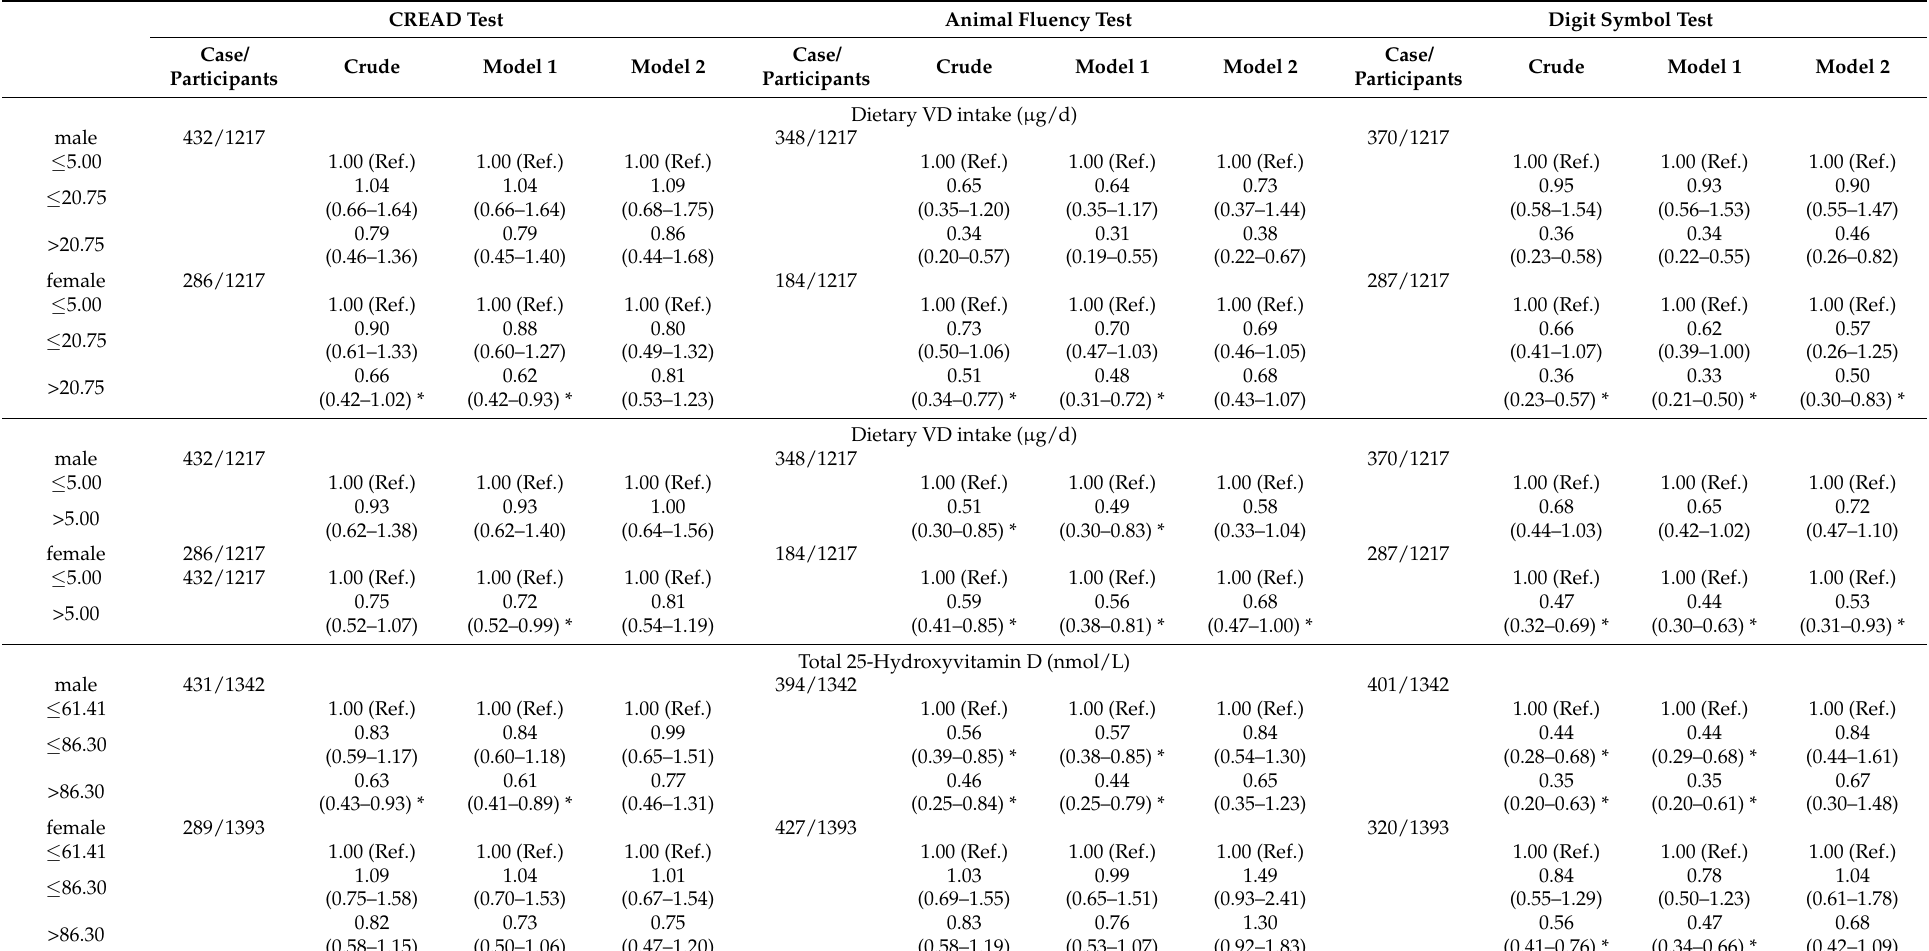
Table 5. Weighted ORs (95% CI) for score on CERAD test, Animal Fluency test and DSST across dietary VD intake and serum total 25(OH)D, stratified by gender, NHANES